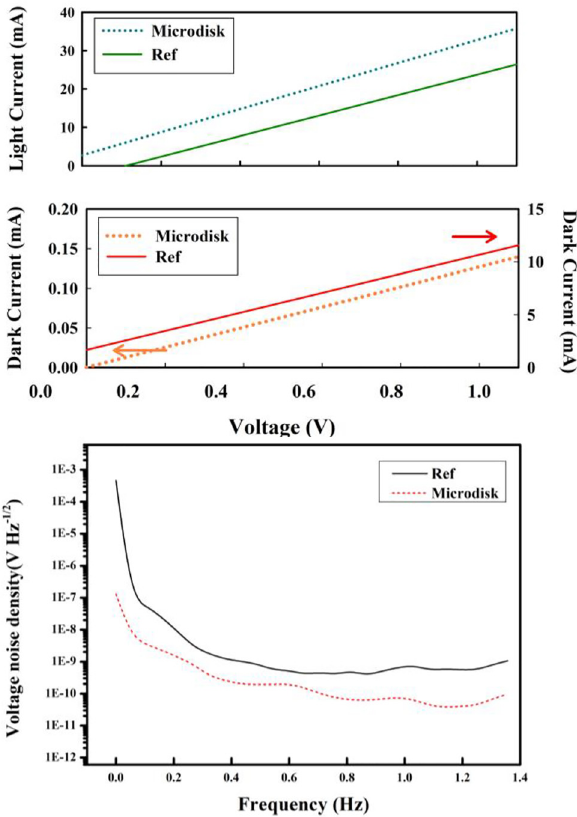
Figure 3: Light current, dark current with the applied voltage and noise characterization with the frequency at room temperature.